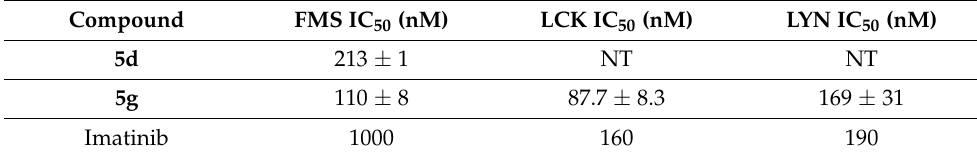
Table 3. IC 50 of most active compounds 5d and 5g .